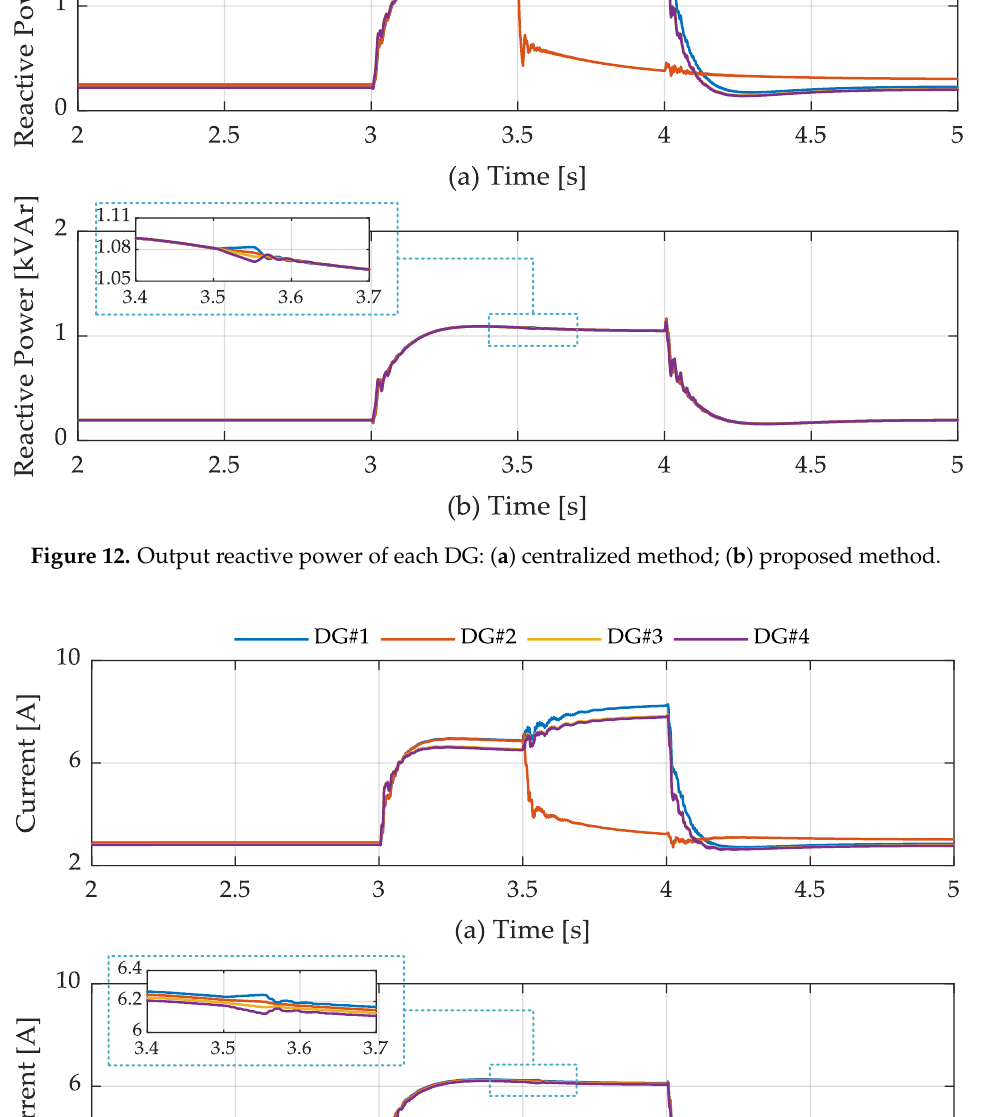
Figure 11. Output voltage of each DG: ( a ) centralized method; ( b ) proposed method.